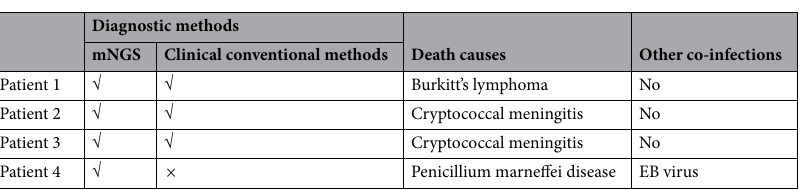
Table 3. Analysis of causes of